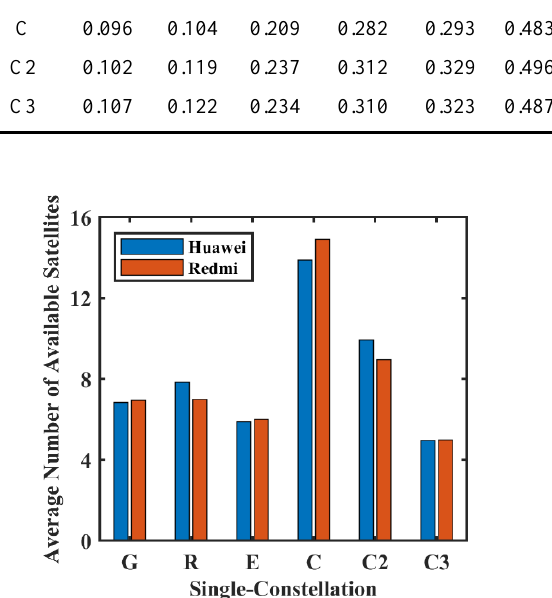
Figure 13. The average number of available satellites for single-constellation in velocity determination